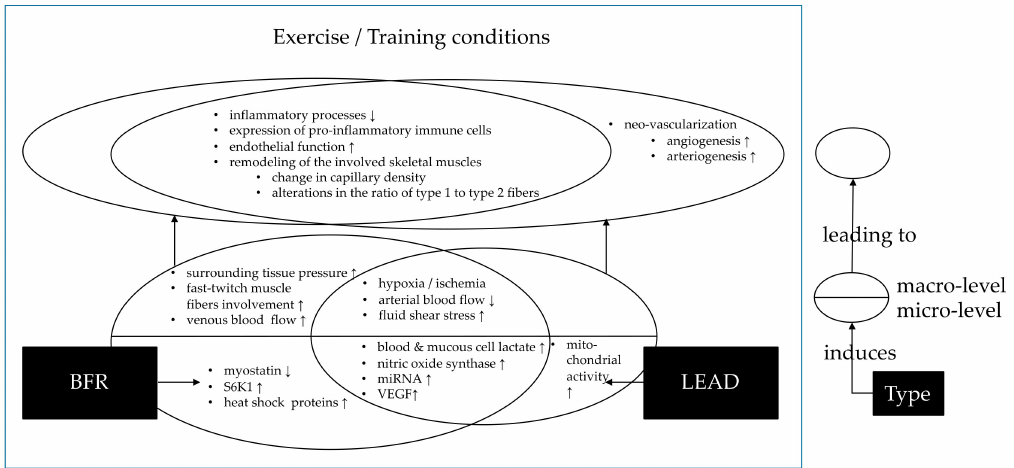
Figure 1. Mechanisms and pathways of how exercise leads to training success in peripheral arterial disease (lower extremity arterial disease (LEAD), right side) and under blood flow restriction (blood flow restriction (BFR) left